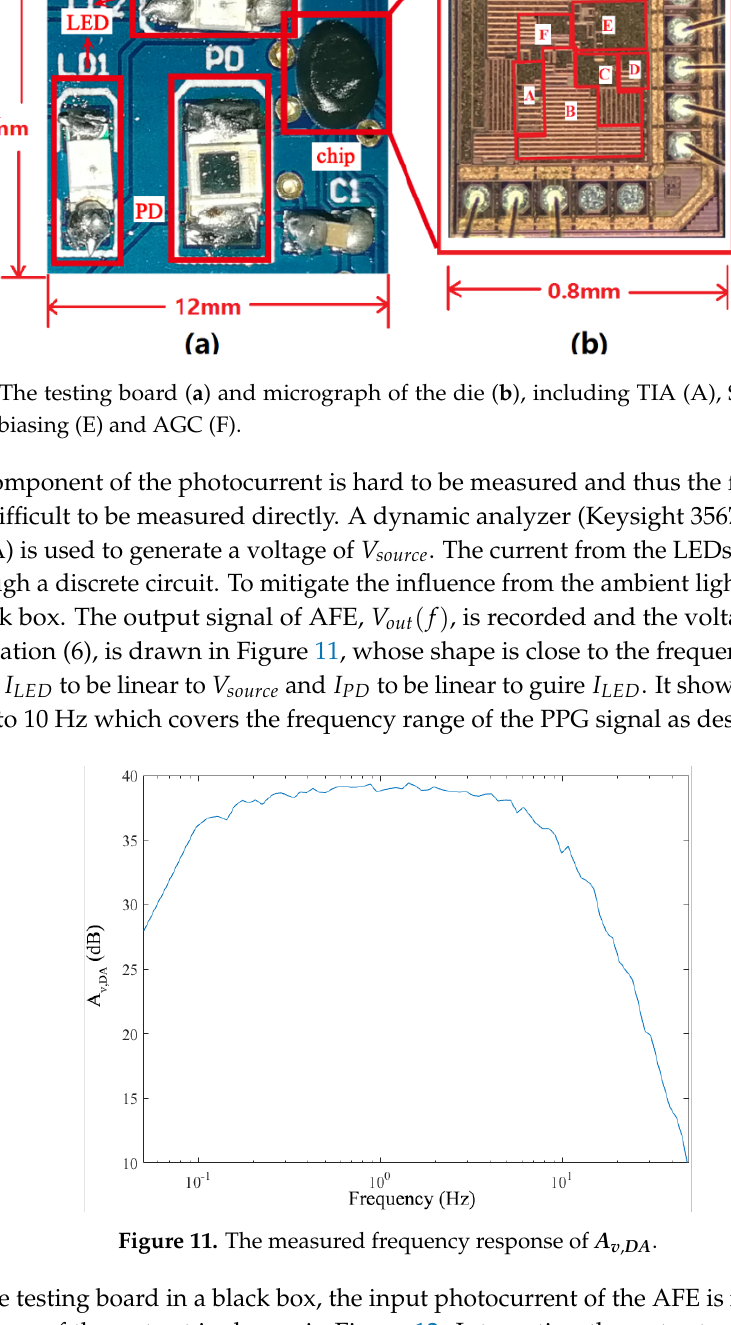
Figure 10. The testing board ( a ) and micrograph of the die ( b ), including TIA (A), SA (B), LPF (C), buffer (D), biasing (E) and AGC (F).